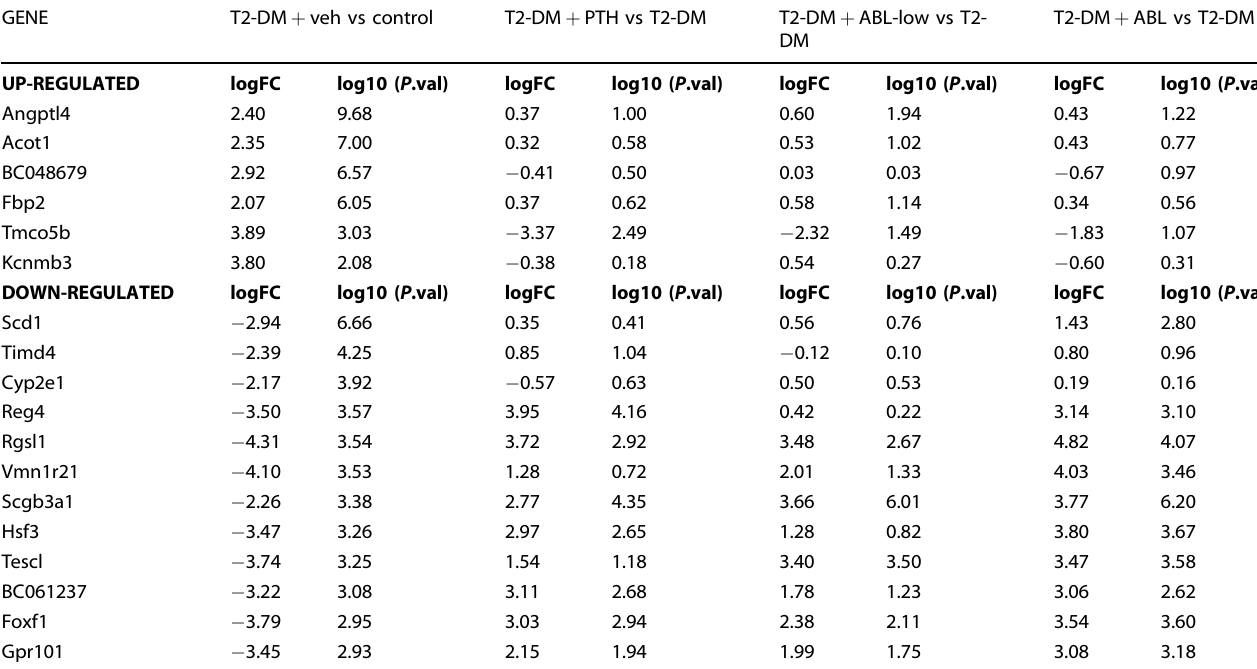
Table 1. Differentially expressed genes in T2-DM mice treated with PTH or ABL (Fig. 4a) GENE T2-DM + veh vs